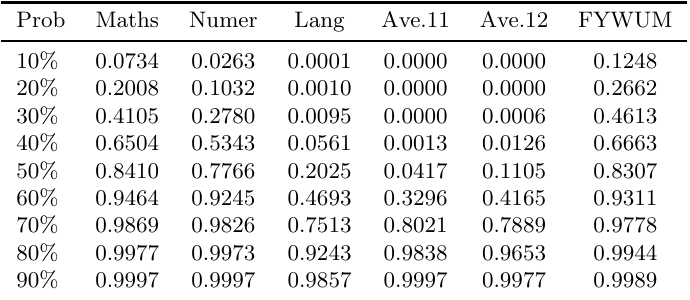
Table 2: Test Battery 2 variables of 1999 intake group: Cumulative probabilities derived from normal